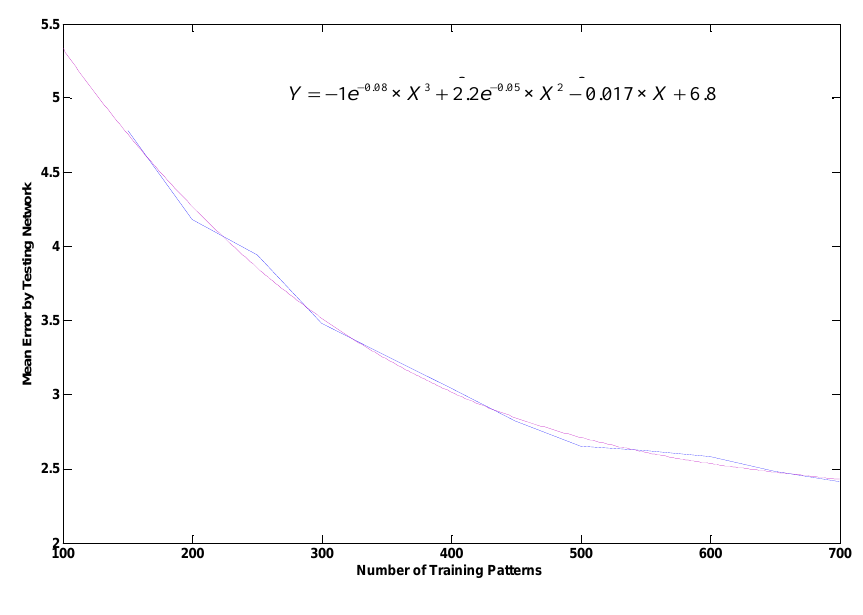
Figure 14. Evolution of mean error in the testing phase with respect to the number of patterns employed in the training phase. Fitting curve is red line and real curve is blue